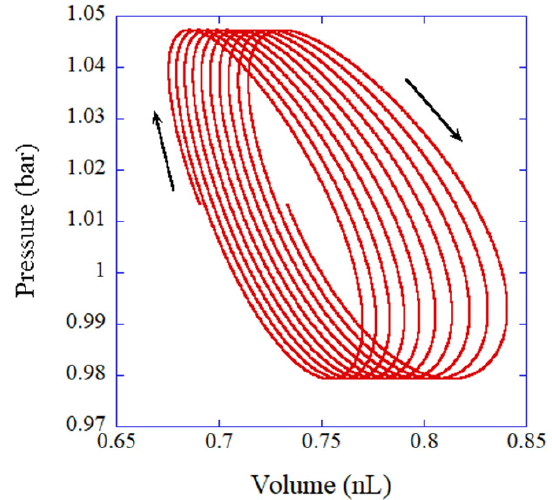
Figure 16. The p-V diagram according to the numerical simulation of the ODE model for a fluid parcel in a traveling-wave thermoacoustic engine near the cold end of a wet stack. Reprinted with permission from Ref. [91] Copyright 2021, AIP Publishing.